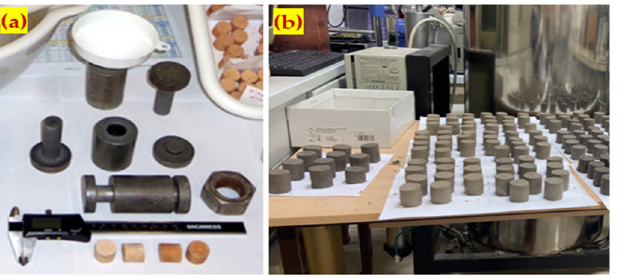
Figure 2. Details of specimen preparation: ( a ) tools used for compaction; ( b ) appearance of com- pacted specimens.